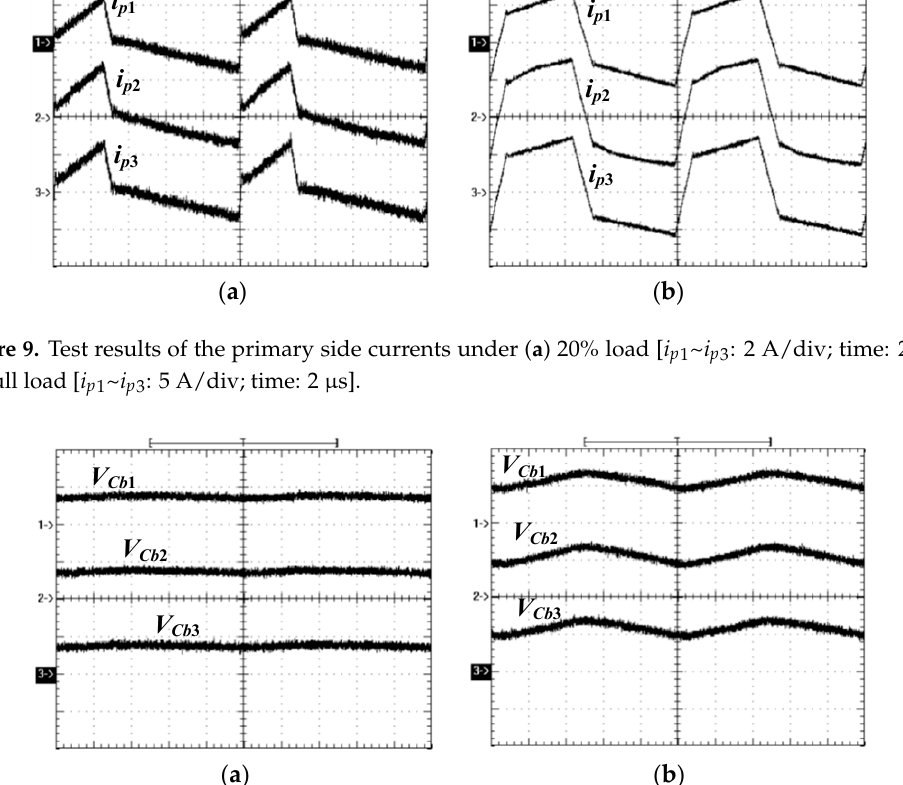
Figure 10. Test results of the primary capacitor voltages under ( a ) 20% load [ V Cb 1 ~ V Cb 3 : 100 V/div; time: 2 µs]; ( b ) full load [ V Cb 1 ~ V Cb 3 : 100 V/div; time: 2 µs].